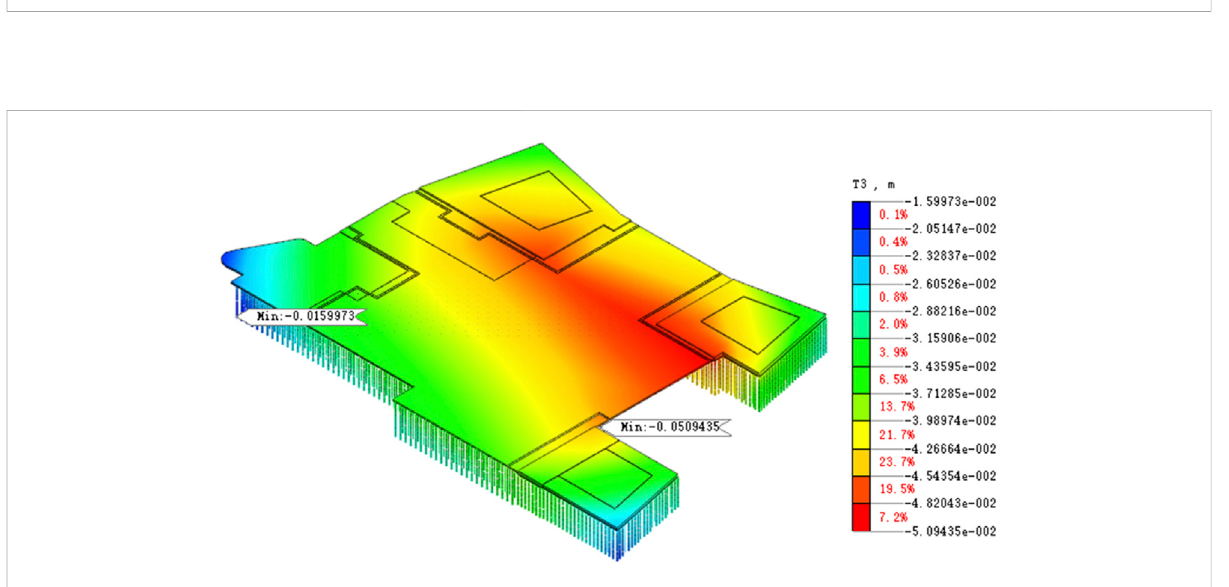
FIGURE 7 Scheme combination 9: overall settlement contour diagram.